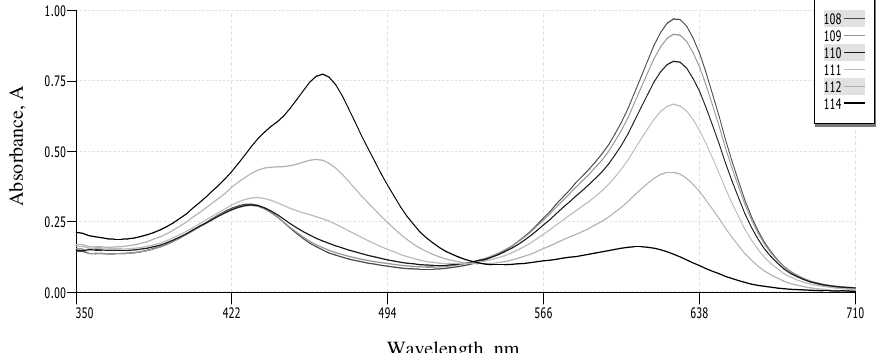
Figure 1. Absorption spectrum for the vanadium(V) -MG-BrO 3− system with time.